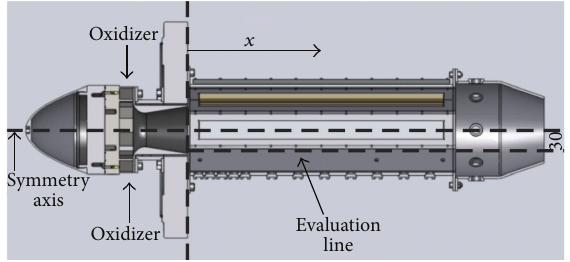
Figure 1: Combustor